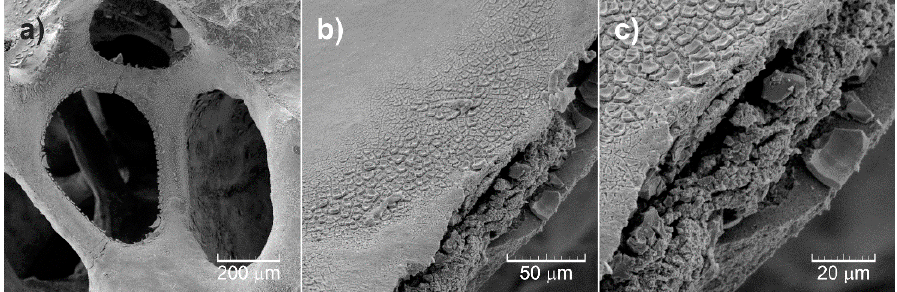
Figure 5. SEM of TiO 2 -coated Al 2 O 3 foam: ( a ) network, ( b ) surface at high resolution (HR), ( c ) crack pattern of TiO 2 coating layer visible on micrographs at high magnification.